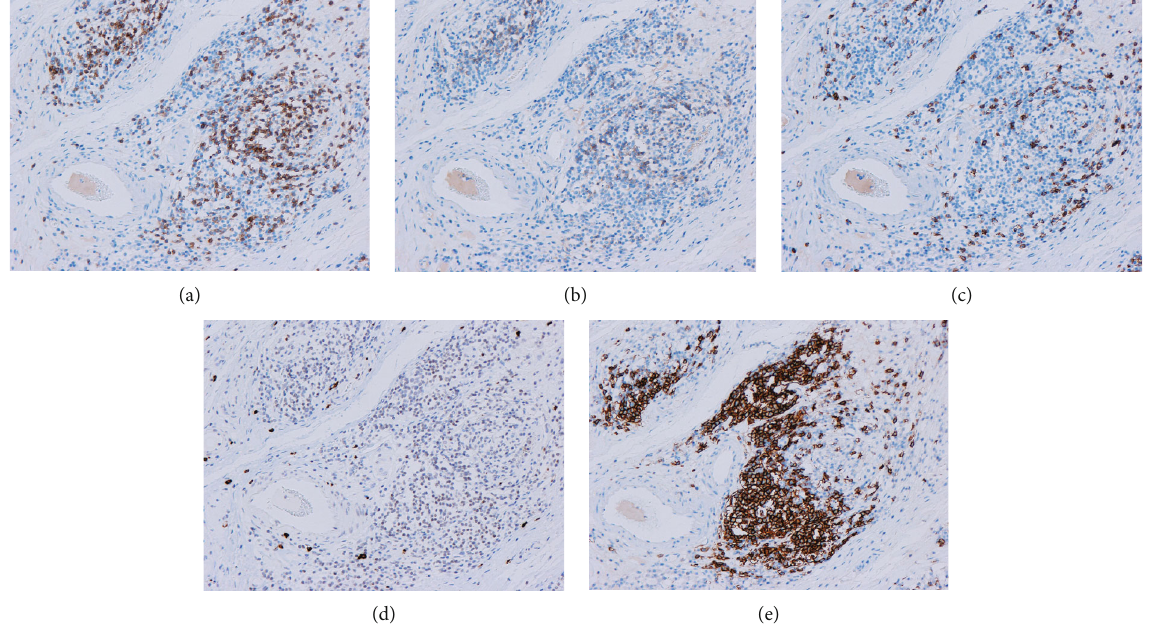
Figure 3: Pathological fi ndings. Immunostaining shows that CD3+, CD4+, and CD8+ T cells mainly in fi ltrate the veins, and CD20+ B cells in fi ltrate the surrounding areas. Activated natural killer cells and cytotoxic T cells that are positive for granzyme B have a nonspeci fi c distribution. (a) CD3. (b) CD4. (c) CD8. (d) Granzyme B. (e)